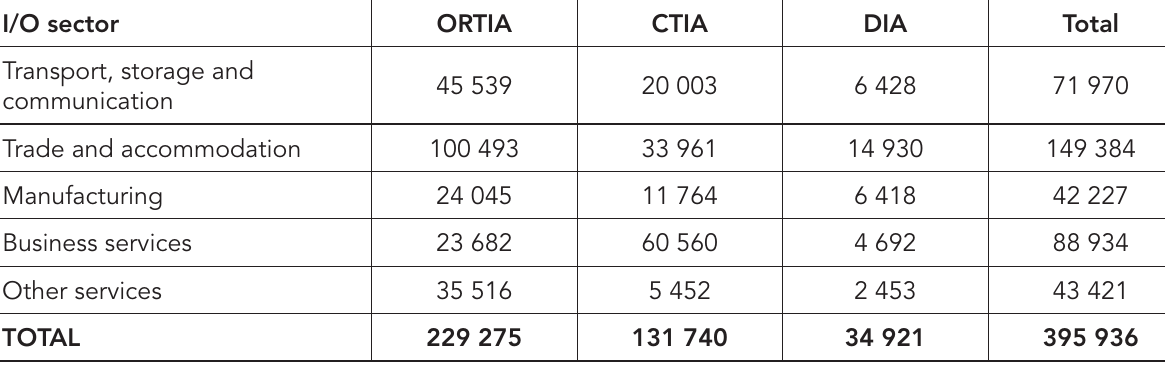
Table IV: Overall combined employment impact of ORTIA, CTIA and